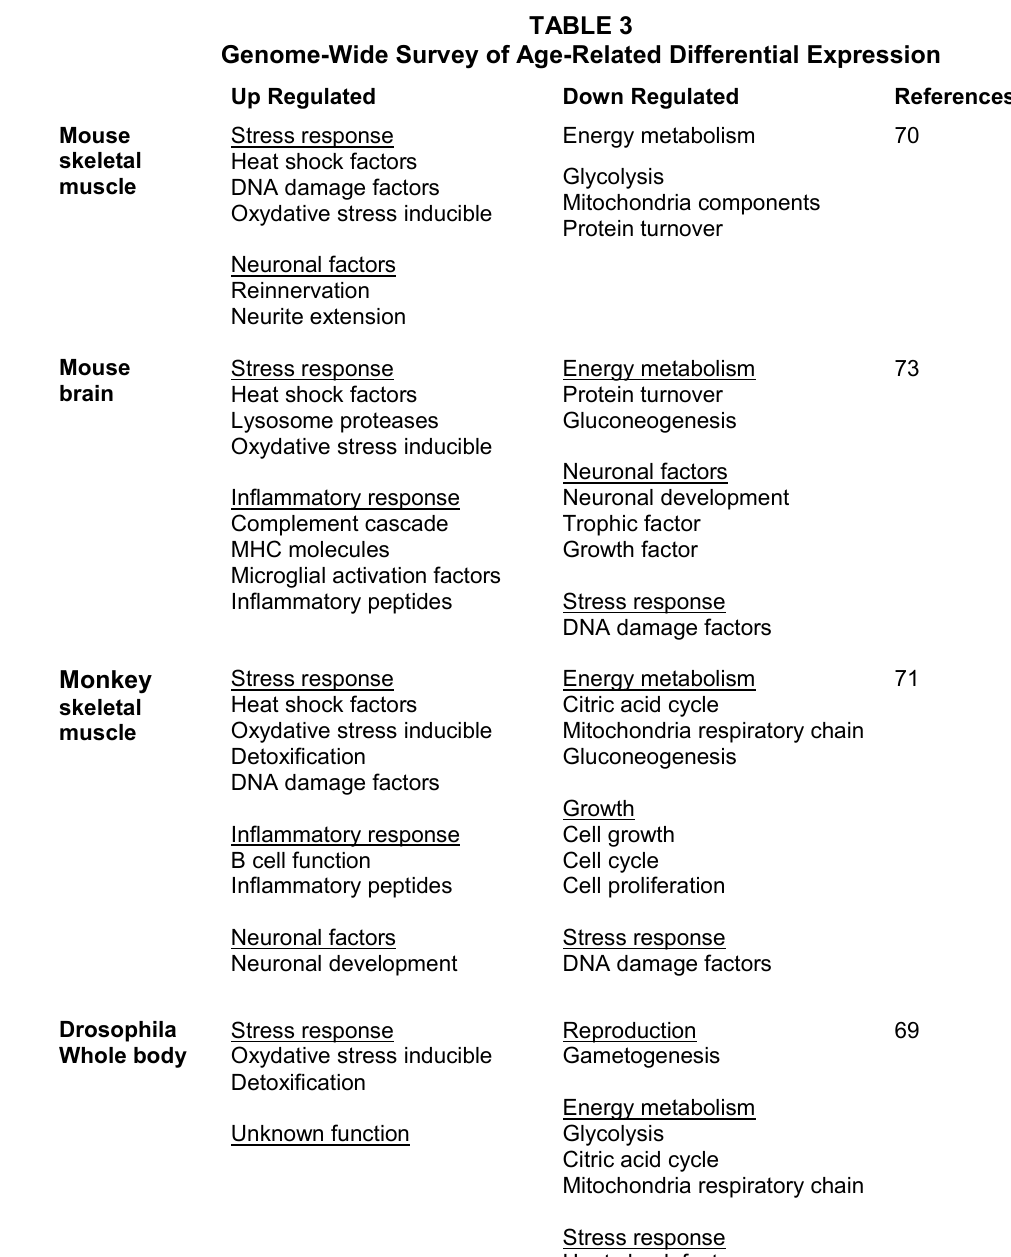
Genome-Wide Survey of Age-Related Differential